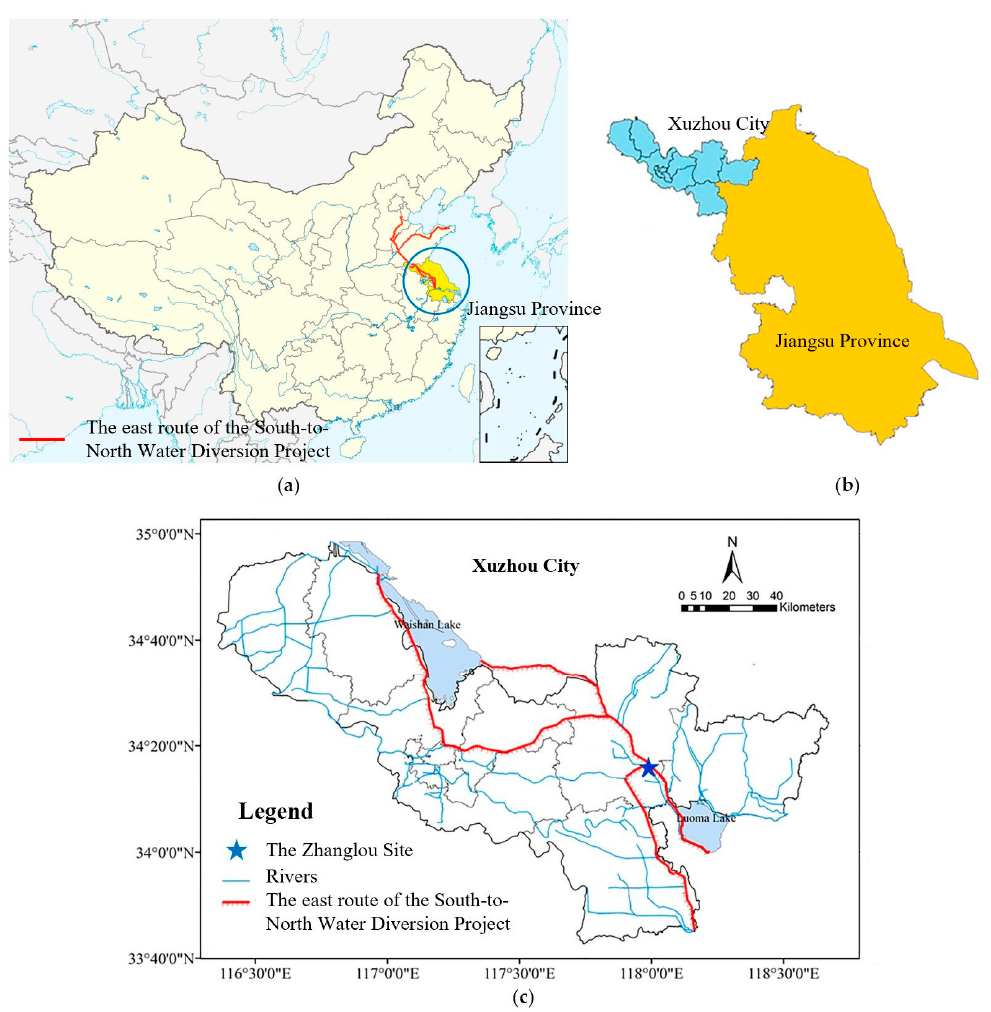
Figure 1. ( a ) Location of east route of the South-to-North Water Diversion Project in China; ( b ) Location of the Xuzhou City in Jiangsu Province; ( c ) Location of the Zhanglou sampling site.